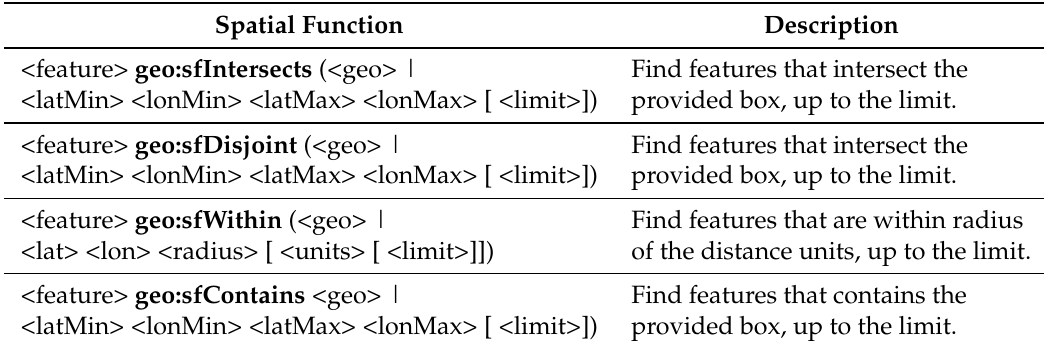
Table 2. Spatial property functions.